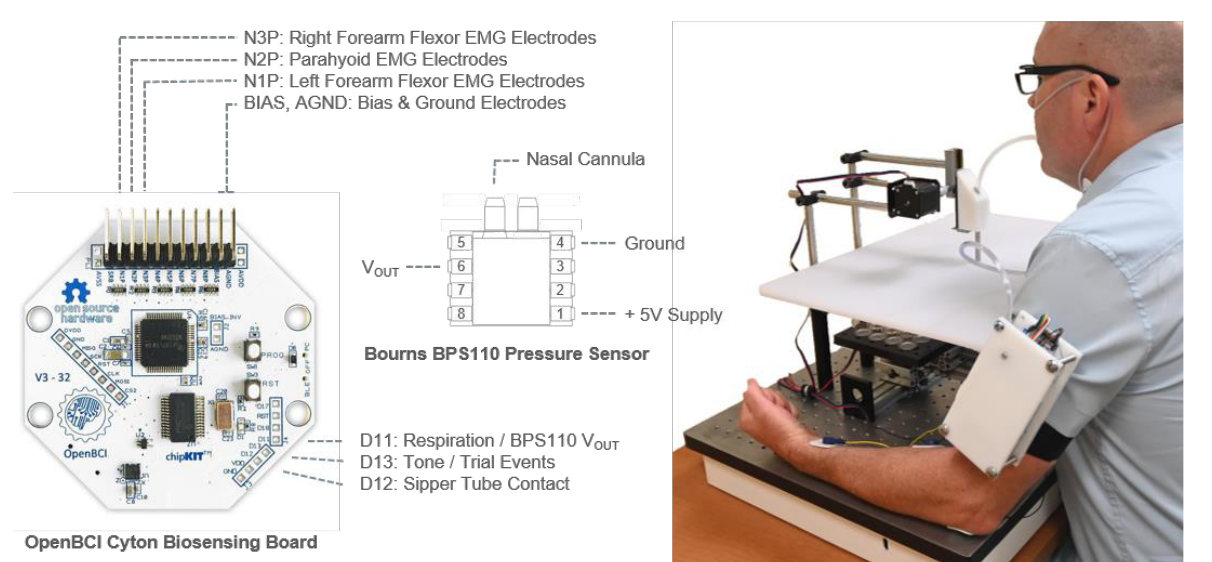
Figure 1. System components and experimental setup. (Left) OpenBCI Cyton biosensing board (image used with permission) and Bourns BPS110 differential pressure transducer. (Right) Behavioral testing equipment and wearable biosensing system. Forearm flexor behavioral responses and swallowing were monitored by surface electrodes connected to low-noise analog-to-digital converter input pins (ADS1299 N1P, N2P, N3P). Intranasal air pressure was monitored through a nasal cannula connected to one port of the pressure transducer, with output voltage sent to one of three general-purpose analog inputs (D11). Two additional analog inputs (D12, D13) were used to monitor trial events (tones) and mouth contact with fluid via the sipper tube. The BCI system was housed within an acrylic frame, which also contained a separate microcontroller (Arduino Uno) and battery pack for system expansion and power. Physiological signals were sent from the Cyton board via Bluetooth to a laptop computer (not shown) in an adjacent room.